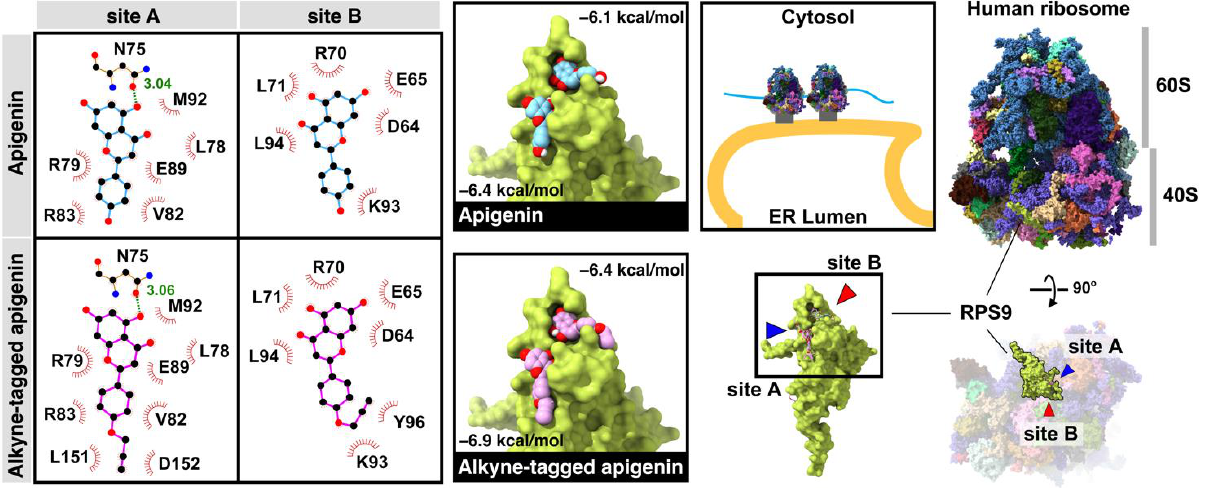
Figure 4. The binding interaction and conformation of apigenin and alkyne-tagged apigenin on the ribosomal protein S9 (RPS9) at sites A and B.